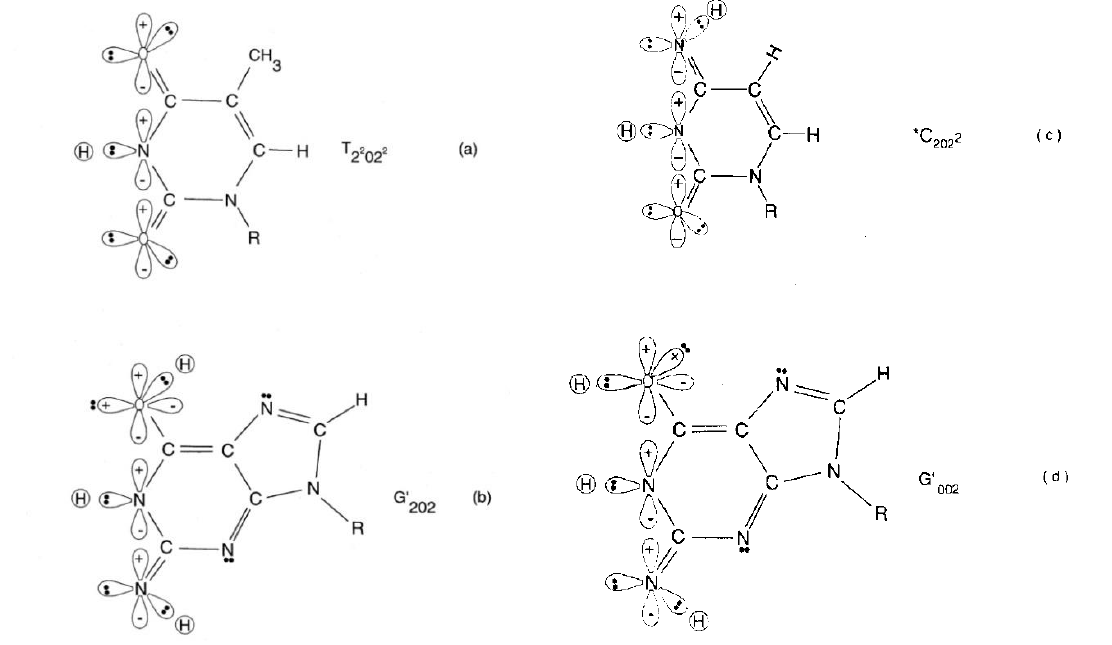
Figure 4. Approximate proton electron hydrogen bonding structure ―seen by‖ transcriptase systems when encountering (a) normal thymine, T2 2 0 2 2 ; (b) coherent enol-imine G′2 0